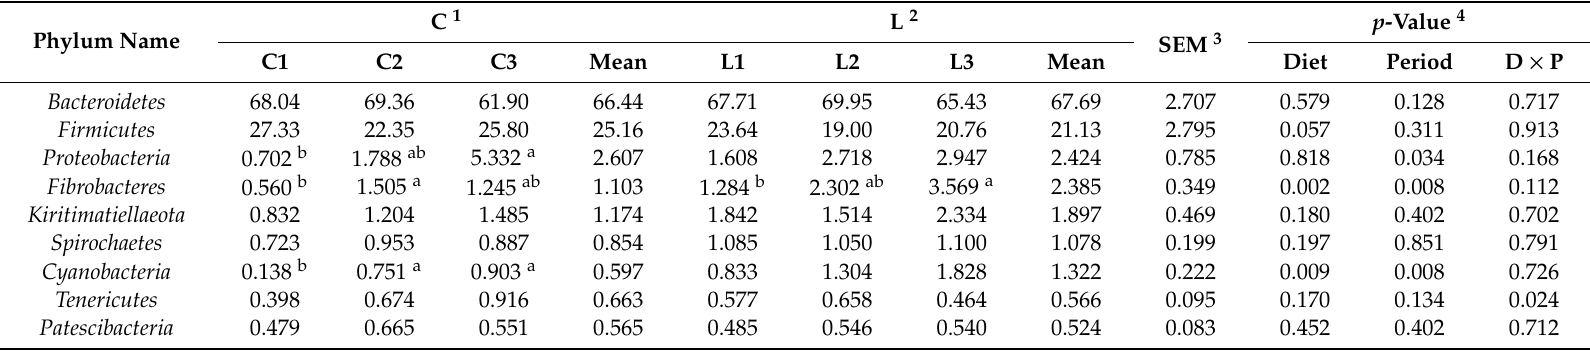
Table 3. Phylum (relative abundance > 0.5%) composition for rumen samples collected at three monthly intervals in two diet